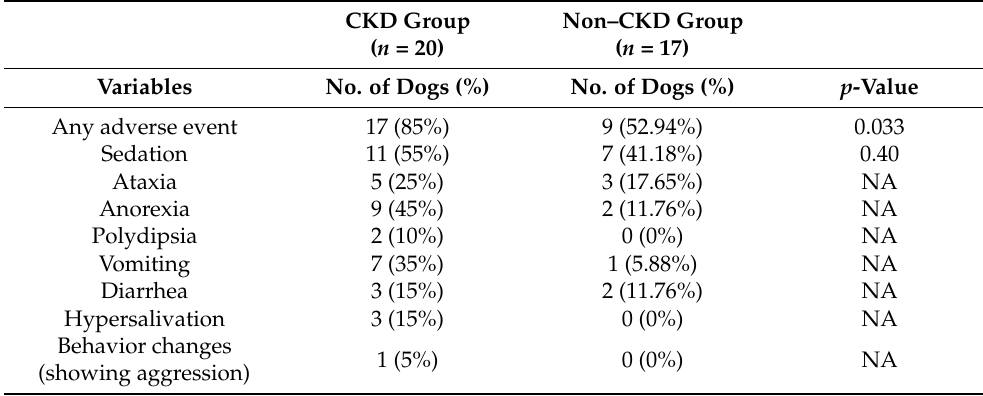
Table 4. Side-effects of the oral LEV were observed in the CKD group/non–CKD